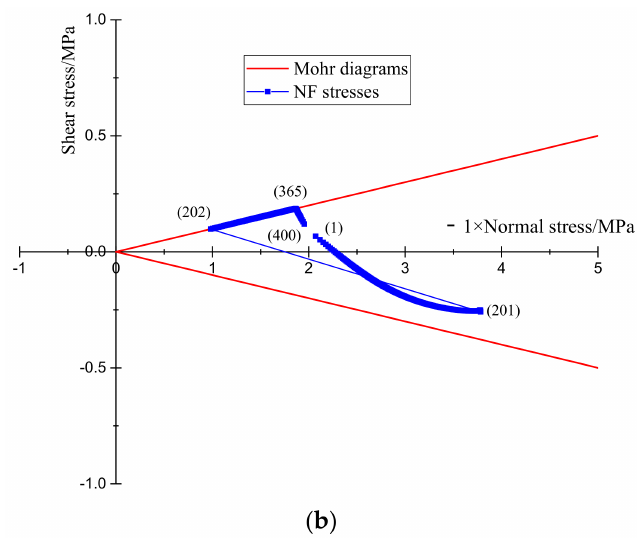
Figure 15. Mohr diagrams for the entire sets of elements along the NF. ( a ) Moderate strength NF ( c = 2.2 MPa, φ = 26.6 ◦ ); ( b ) Weak strength NF ( c = 0.0 MPa, φ = 5.7 ◦ ).